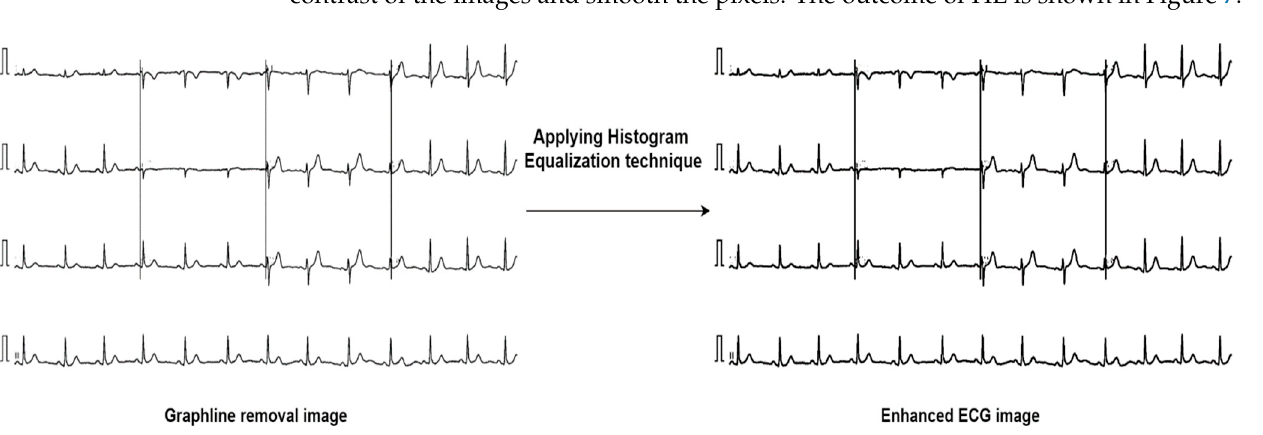
Figure 8. Original image (after label removal) and the enhanced image. We used the original and enhanced images of the same signal to calculate MSE, PSNR, SSIM, and RMSE for a total of 1932 images, but it is not convenient to present all the values. We, therefore, randomly select twenty images for an indication of the values, as seen in Table 1. For all 1932 images, the average value of MSE is 0.147, PSNR is 36.98,